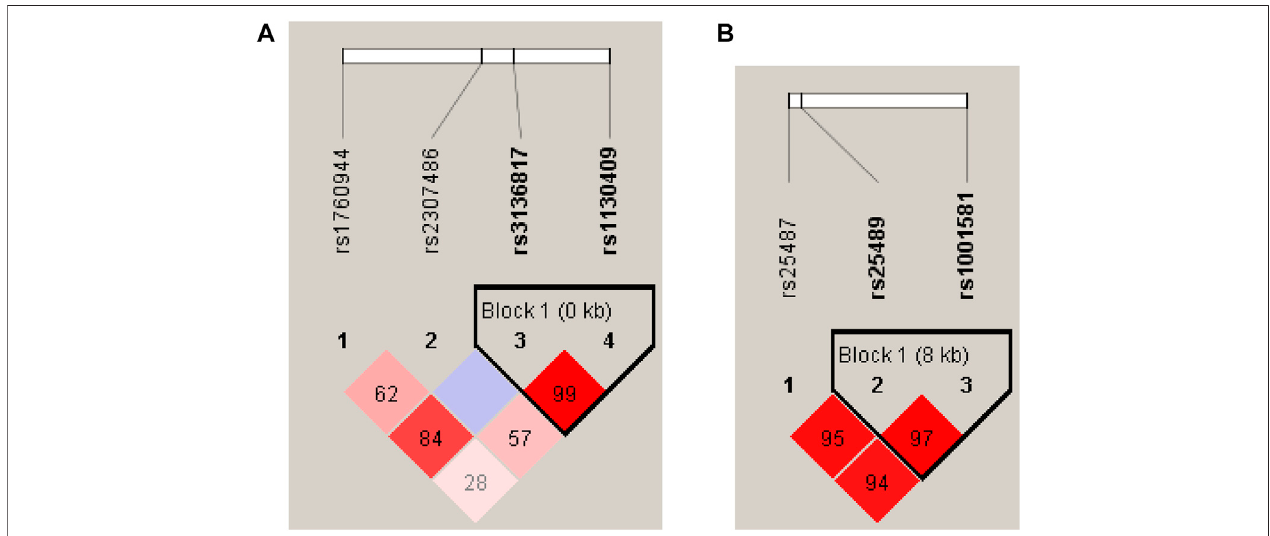
FIGURE 1 | The results of LD analysis. (A) Haplotype block map for 4 SNPs of the APEX1 gene, (B) Haplotype block map for 3 SNPs of the XRCC1 gene. The haplotypeswereconstructedaccordingtotheprevalenceofSNPsandLDamongthem.Numbersinsquaresindicate D ’ values.ThewhitecellindicatesD ’ < 1andLOD (log of the likelihood odds ratio) < 2; The blue cell indicates D ’ = 1 and LOD < 2; the pink or red cell indicates D ’ < 1 and LOD ≥ 2; The bright red cell indicates D ’ = 1 and LOD ≥ 2.